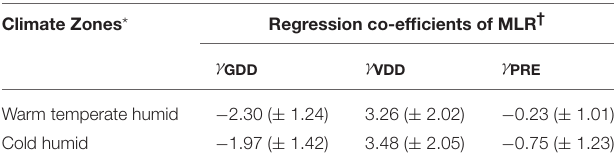
TABLE 1 | Statistics of the regression coefficients between winter wheat yields and climate variables in major climate